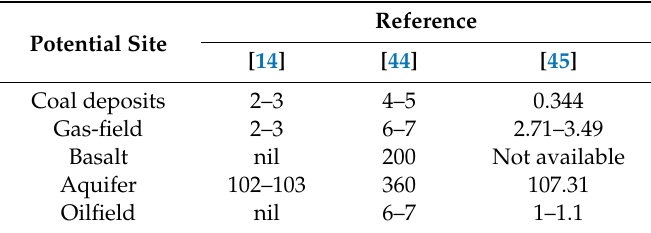
Table 6. Storage possibilities for CO 2 in an Indian